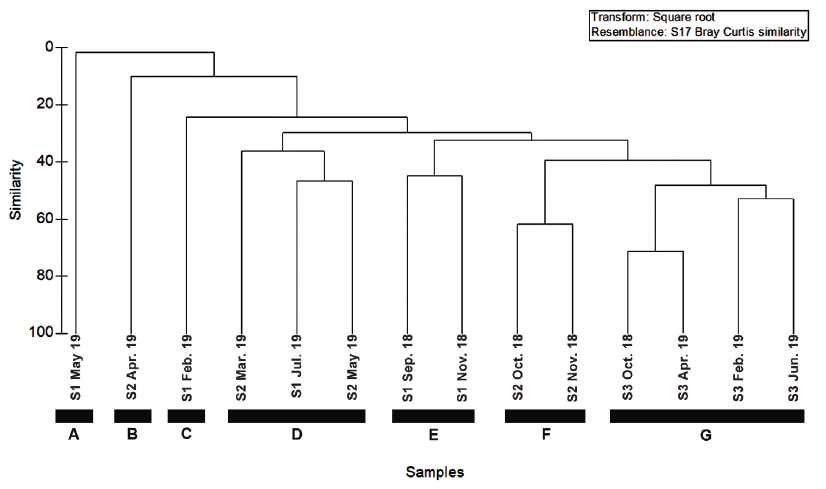
Figure 5. Cluster diagram by group-average clustering based on the Bray-Curtis similarity index using the relative abundance of species.